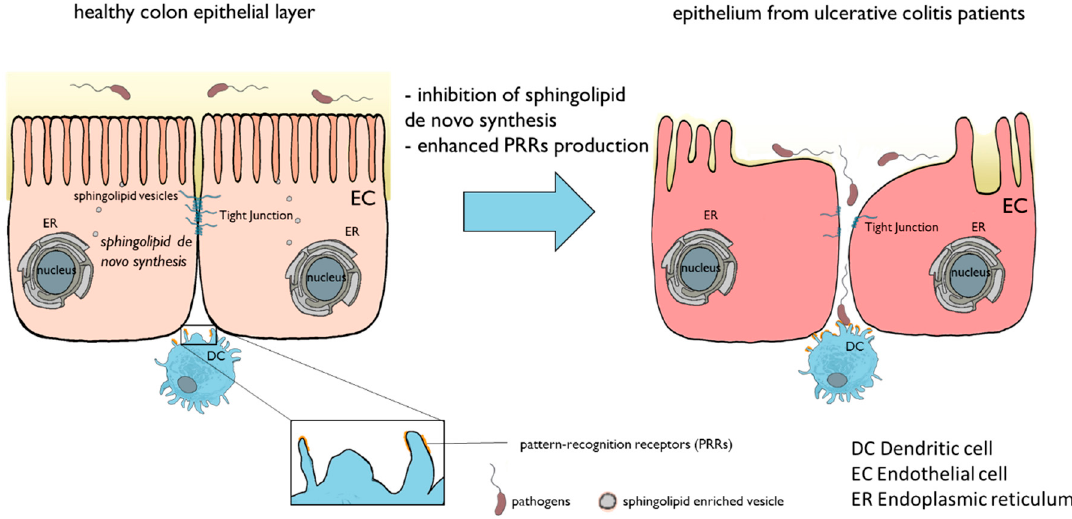
Figure A1. In healthy colon tissue, tight junctions stabilize the epithelial layer. The functionality of the tight junctions is dependent on proper membrane lipid composition, which is warranted by, e.g., vesicular delivery of sphingolipids that are built de novo in the endoplasmic reticulum (ER). In colon tissue from ulcerative colitis patients, de novo sphingolipid synthesis is reduced, leading to the disruption of membrane integrity. Furthermore, LacCers, which can function as pattern-recognition receptors, are upregulated, leading to an enhanced binding of pathogens and thereby, activation of immune cells.